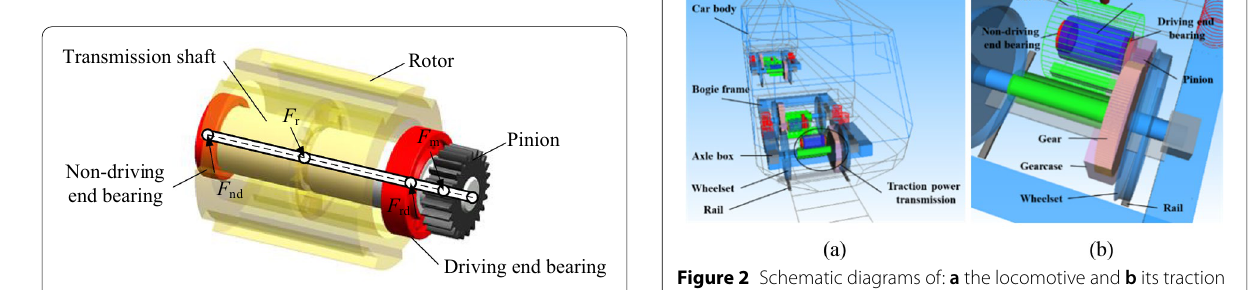
Figure 1 Schematic diagram of the locomotive traction motor